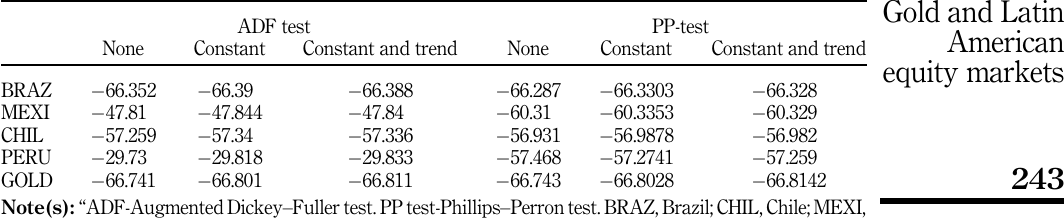
Table 2. Unit root